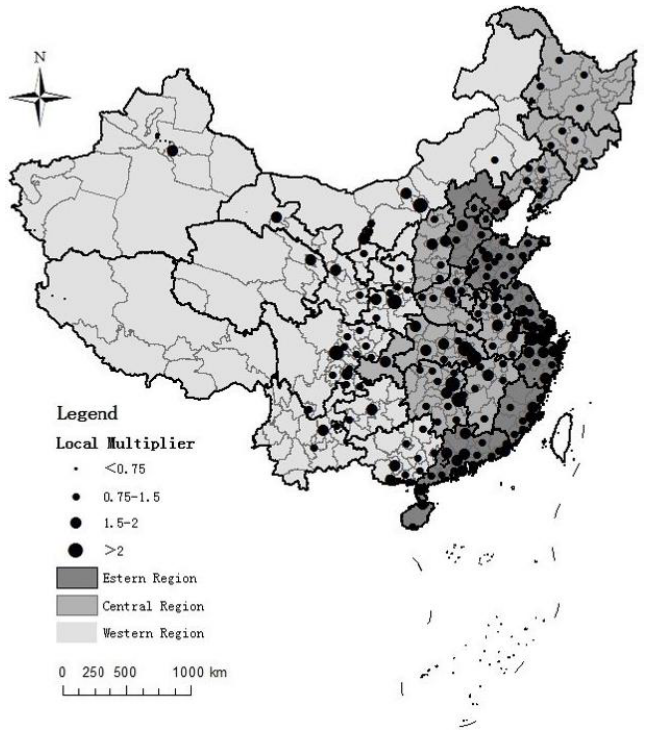
Figure 2. The employment multiplier distribution of expanding cities in China.